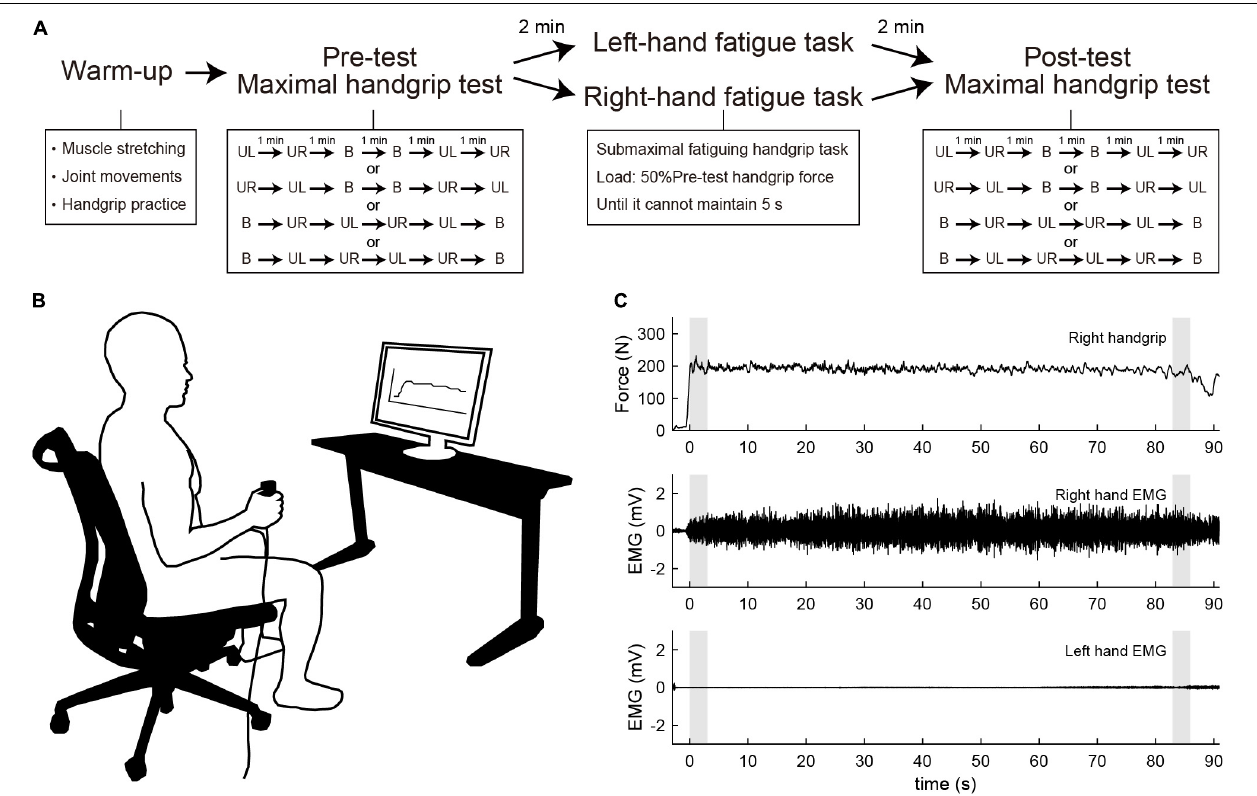
FIGURE 1 | (A) Experimental procedure. Participants first performed a warm-up with muscle stretching, joint movements, and handgrip practice. Participants then performed the maximal handgrip test before and after the submaximal fatiguing handgrip task. UL, unimanual left handgrip; UR, unimanual right handgrip; B, bimanual handgrip. (B) Experimental setup during the submaximal fatiguing handgrip task. The participant’s handgrip force and the target line for 50% of pre-test unimanual handgrip force were visually fed back via a 27-inch display located 1 m in front of the participant. (C) Row data traces from a single participant for handgrip force and electromyography (EMG) signal during the right-hand fatigue task. Gray shaded areas indicate the first 3 s and last 3 s of the task. Top, right handgrip force; middle, EMG of right-hand; bottom, EMG of left-hand.